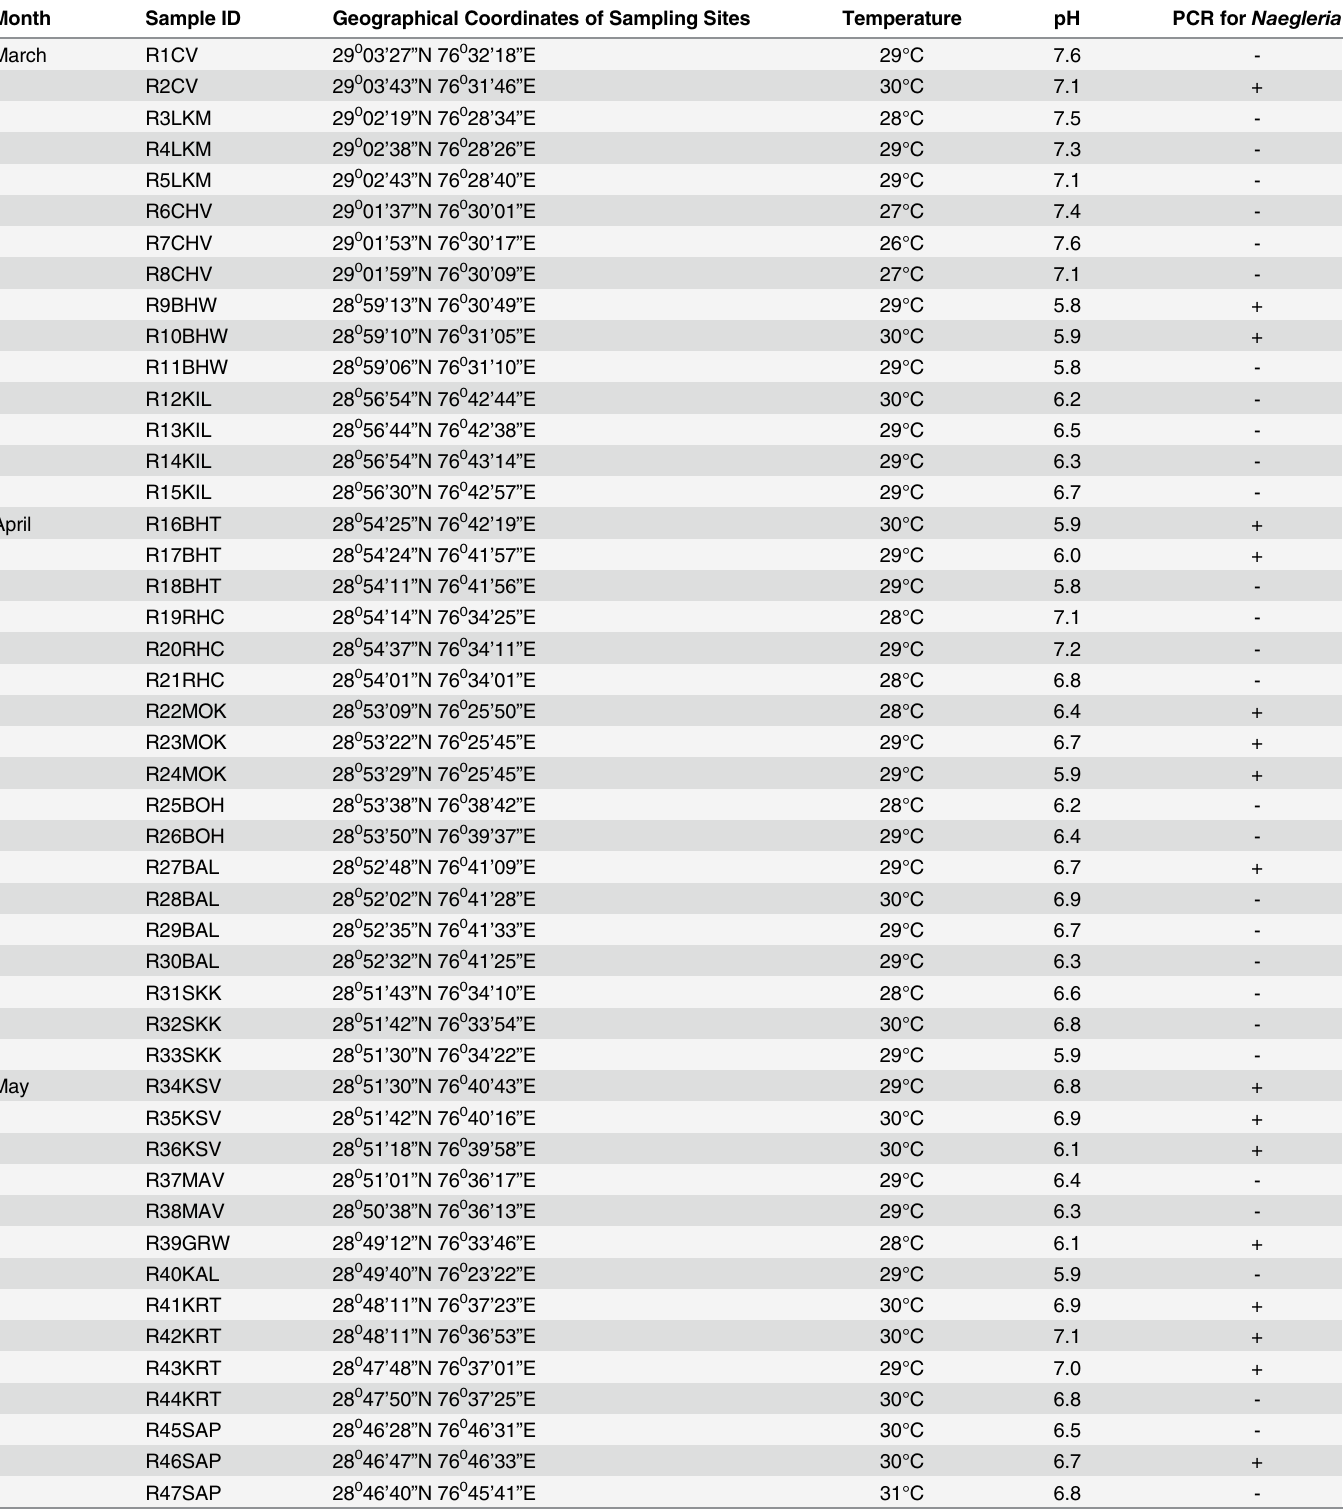
Table 1. Overview of geographic sites sampled for Naegleria